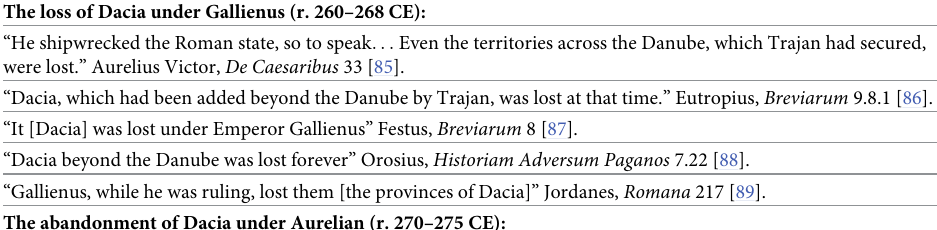
Table 4. Historical accounts pertaining to the loss and abandonment of Transdanubian Dacia in English transla- tion. In chronological order, the surviving sources are Flavius Vopiscus (ostensibly written in 303 CE, although con- sidered late fourth century by most other scholars); Aurelius Victor (361 CE), Eutropius (circa 370 CE); Festus (also circa 370 CE); Orosius (circa 417 CE); and Jordanes (circa 551 CE). Obvious similarities in some of the accounts